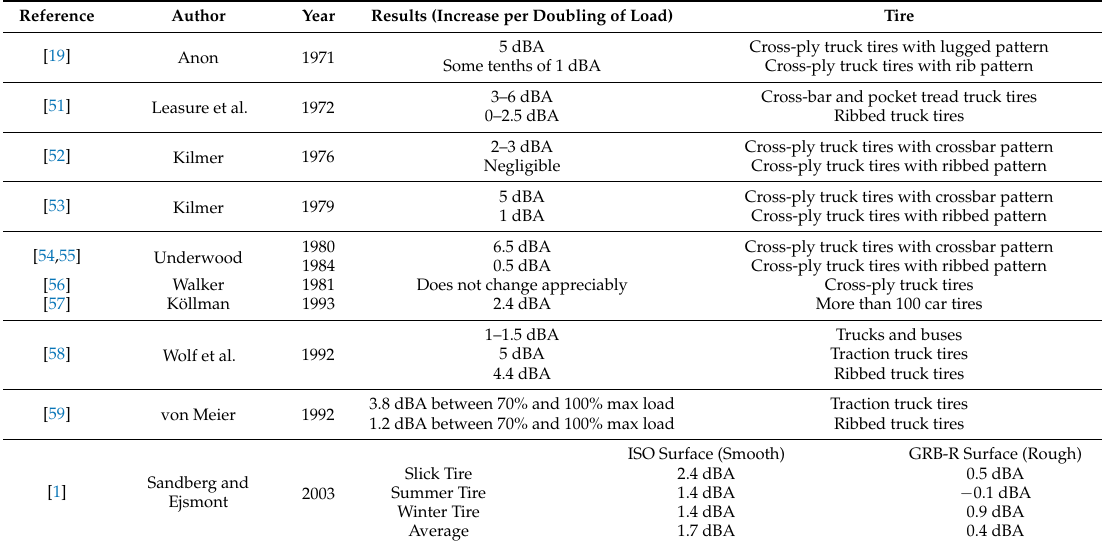
Table 4. Influence of tire load on TPIN (summarized from Sandberg and Ejsmont, 2002 [1]).